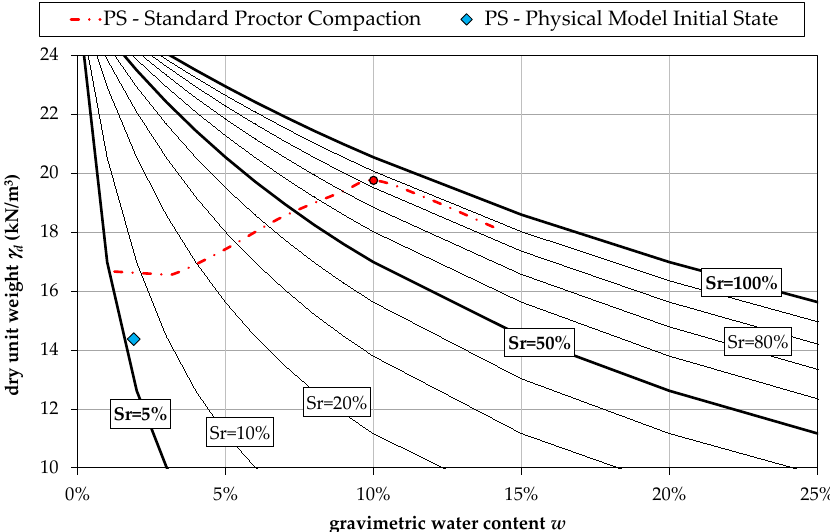
Figure 4. Curve from standard Proctor compaction test of PS (prototype soil) compared to its initial state.